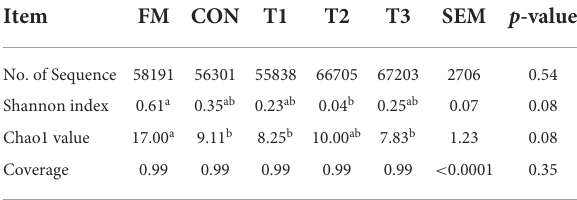
TABLE 3 Diversity indices of the bacterial community of materials or silage of native